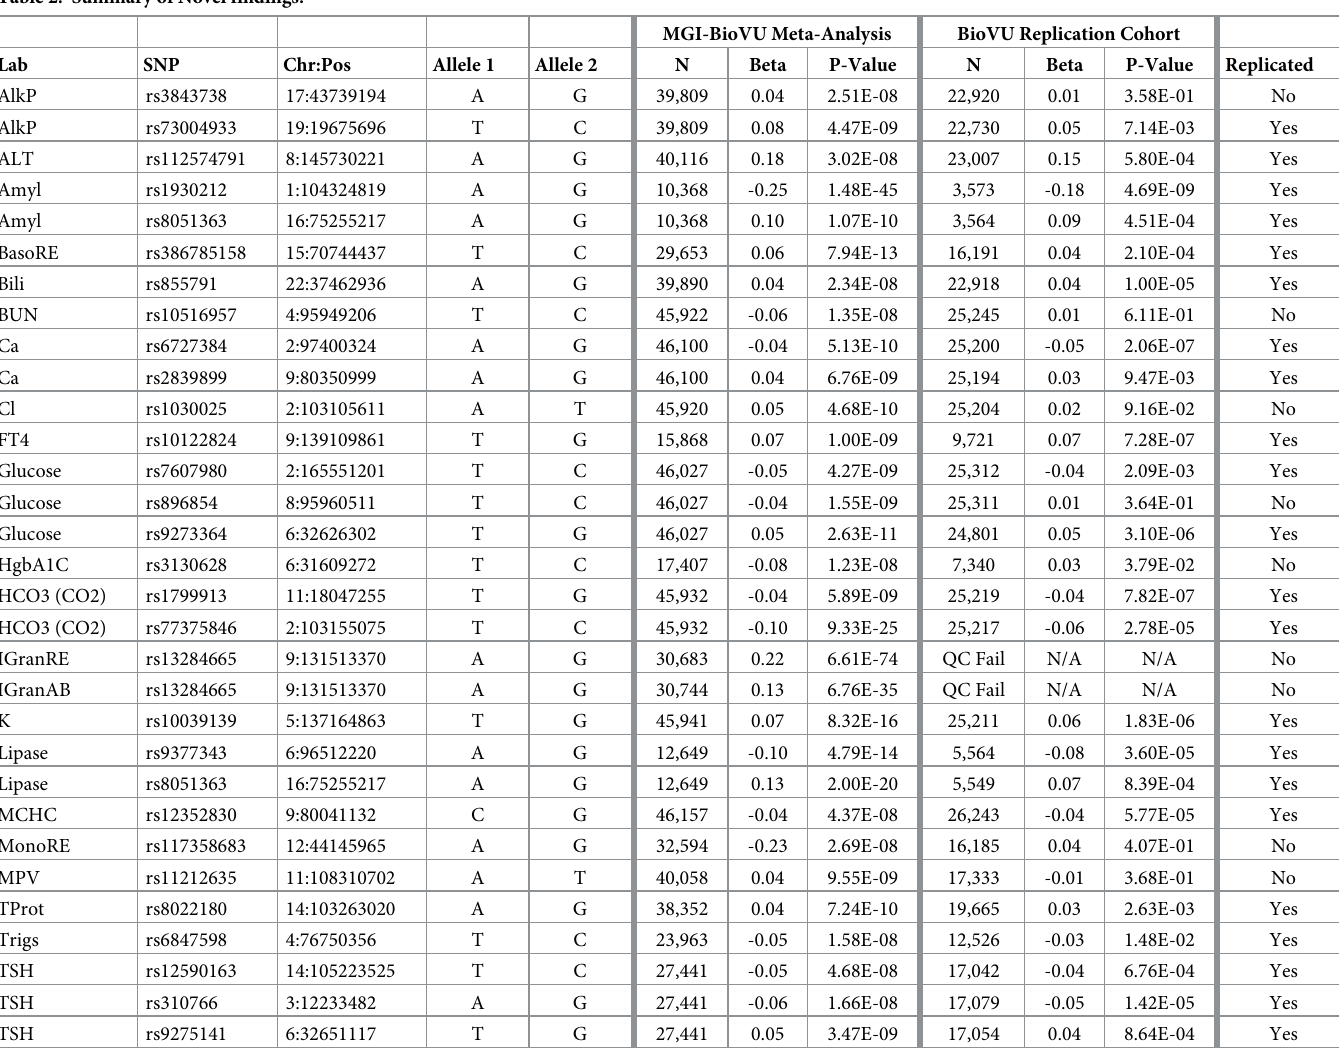
Table 2. Summary of Novel